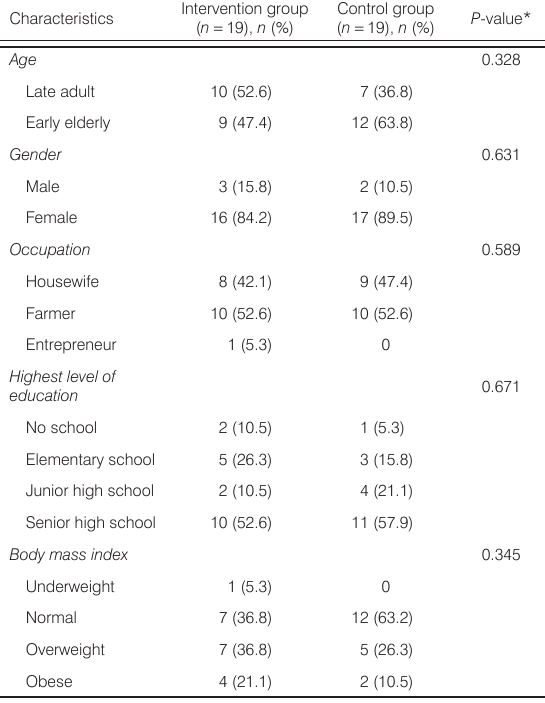
Table 1. Participants’ sociodemographic characteristics ( N =